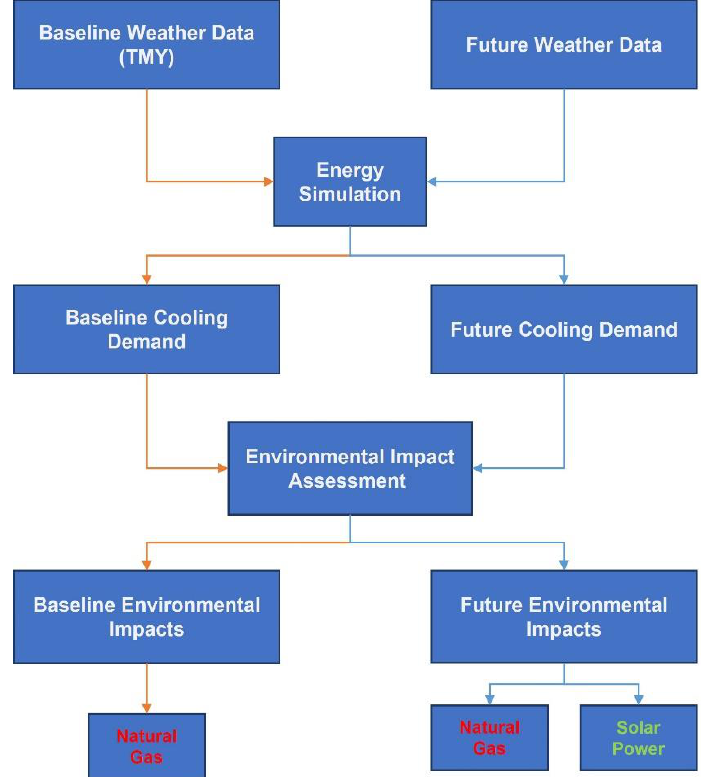
Figure 1. Study Framework.